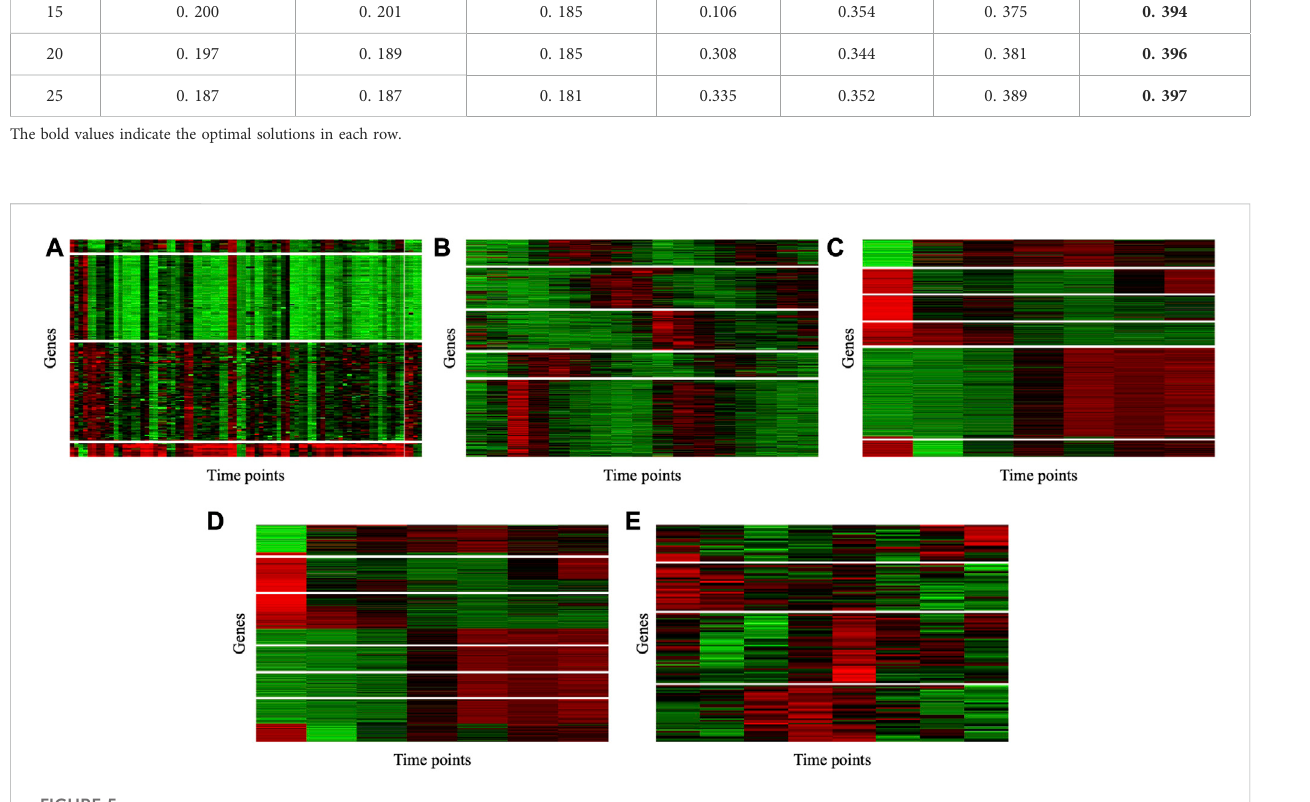
FIGURE 5 Eisen plots of the gene clusters obtianed by MSC-CSMC. (A) Yeast Galactose Metabolism with the number of constraints s =5 (B) Yeast Cell Cycle with the number of constraints s =10 (C) Yeast Sporulation with the number of constraints s =15 (D) Serum with the number of constraints s =20 (E) Arabidopsis with the number of constraints s